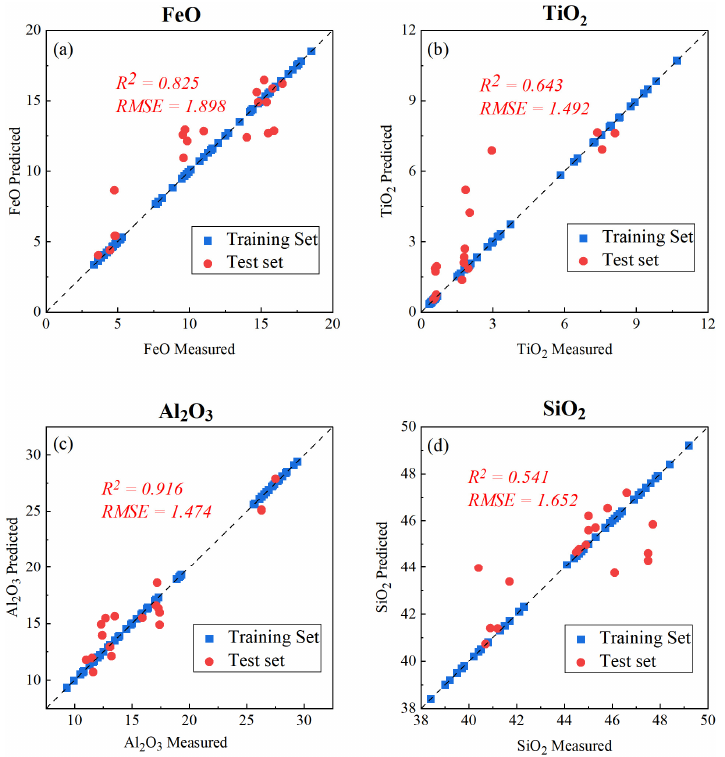
Figure 7. Training and testing accuracy of the Extra-Trees model with chemical abundance based on the original waveband: ( a ) FeO, ( b ) TiO 2 , ( c ) Al 2 O 3 , and ( d ) SiO 2 .